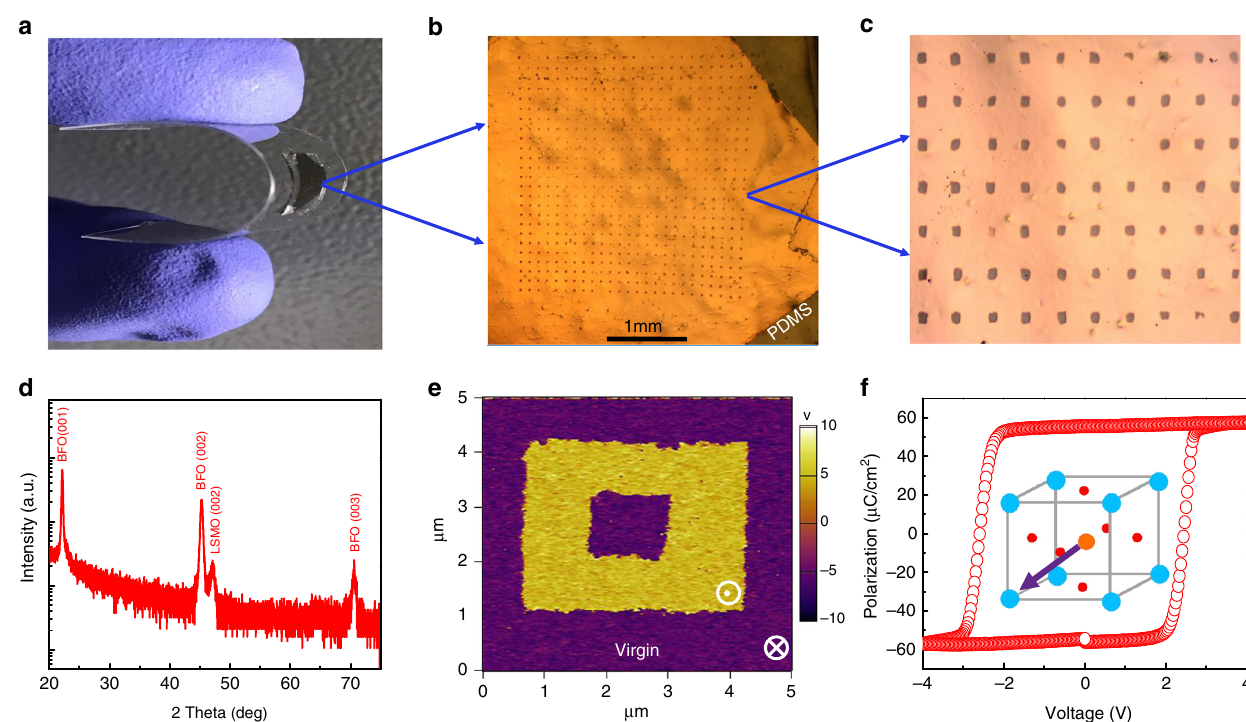
Fig. 2 Fabricated fl exible devices and basic characterizations of freestanding BFO. Optical images of a , the bent Pt/BFO/LSMO sample and b , the fl at one on PDMS supporter with patterned top Pt electrodes. c The local enlarged image of b . d XRD results of the freestanding BFO/LSMO thin fi lms on Si supporter. e Out-of-plane PFM phase images of the freestanding BFO fi lm, with the virgin state and the state after switching using a bias of − 5 and + 5 V, respectively. f P – V loop of the freestanding Pt/BFO/LSMO device. The inset shows the virgin single-domain polarization